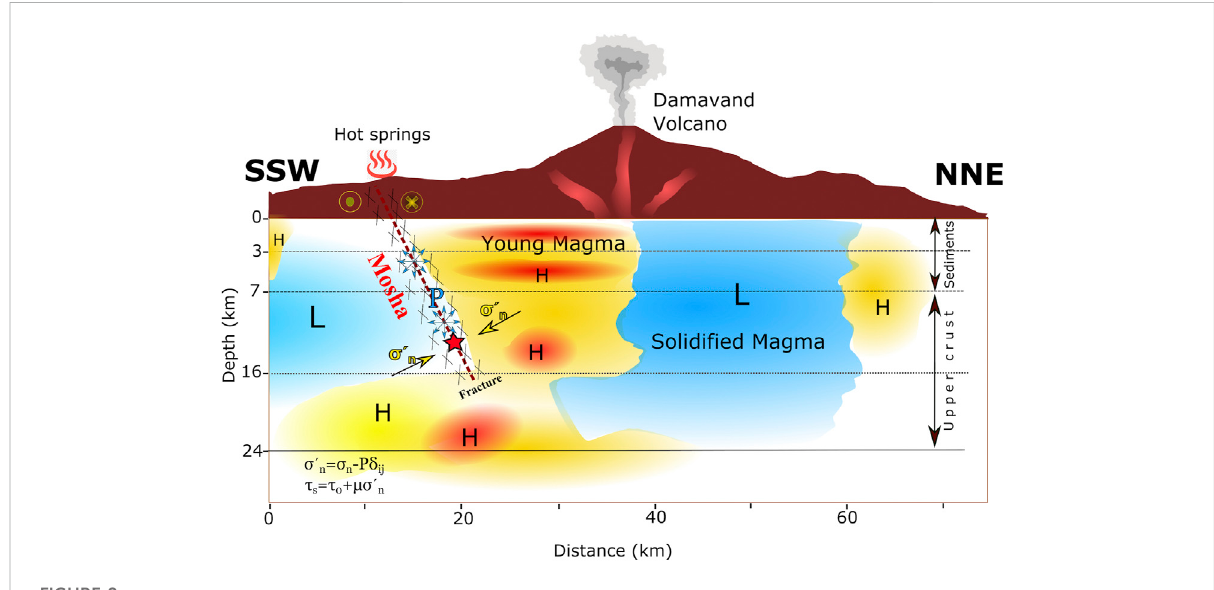
FIGURE 8 Schematicplot illustrating the relation betweenMSH and DMV. Red and blue represent the hot and cool rocks, respectively (afterMostafanejad et al., 2011; Shomali and Shirzad, 2014; Yazdanparast and Vosooghi, 2014; Vajedian et al., 2015; Eskandari et al., 2018). Star is the 7